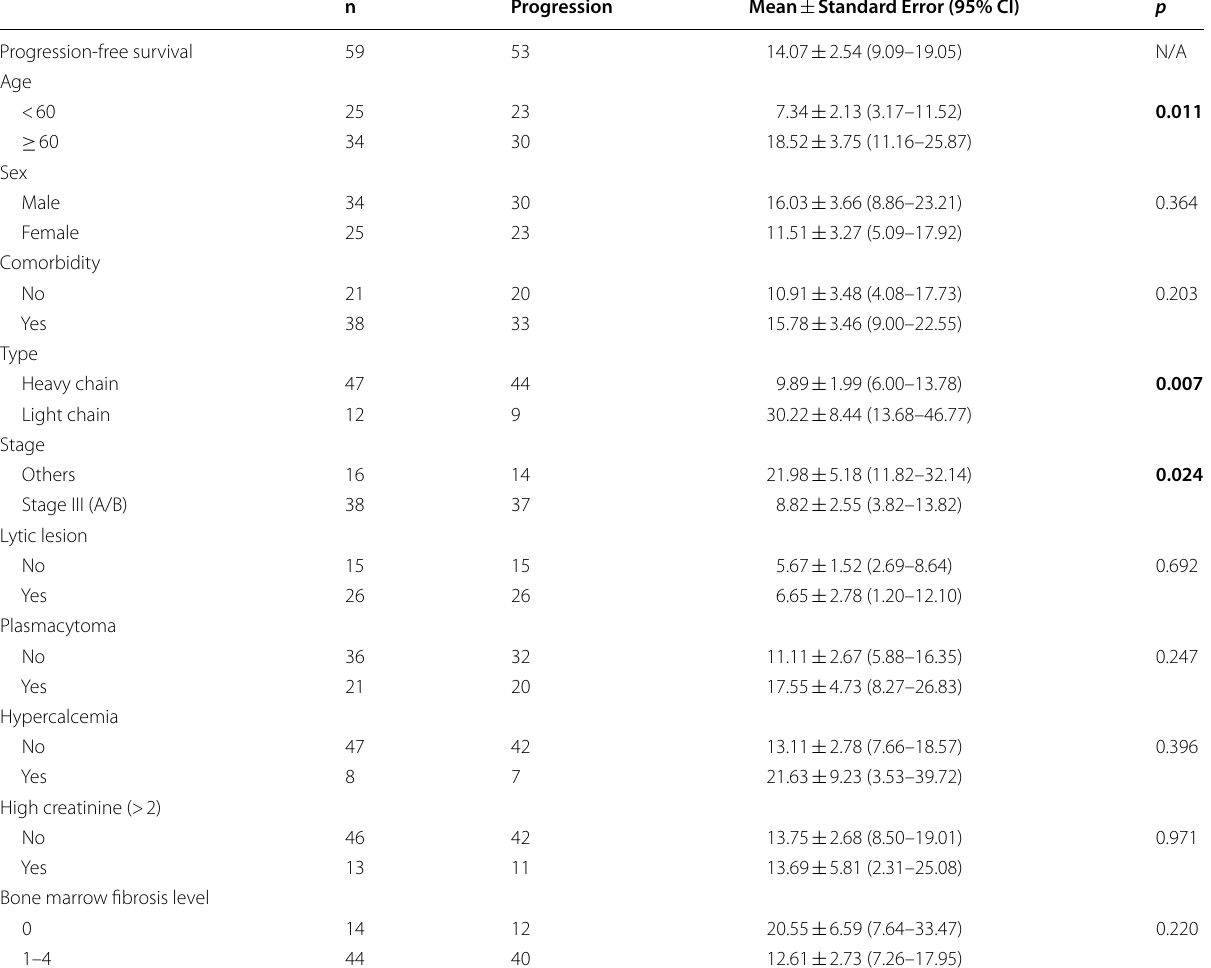
Table 4 Comparison of Progression-free survival times (months) after the first treatment calculated using Kaplan–Meier analysis and groups with Log-rank